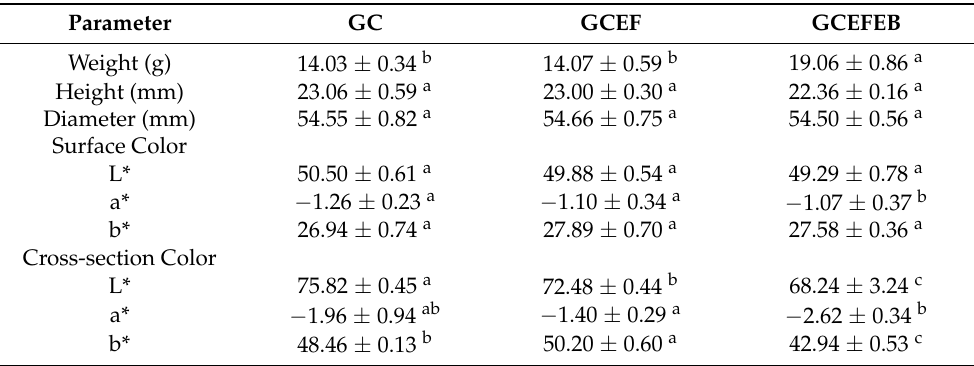
Table 4. Physical parameters ( x ± SD ) of gingerbread cookies covered in chocolate without ad- ditives (GC), and with elderflower dry extract (GCEF), as well as enriched with elderberry juice concentrate (GCEFEB).